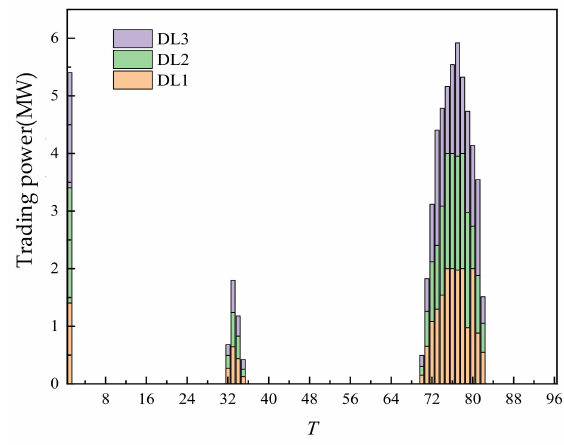
Figure 9. Day-ahead trading of RL.